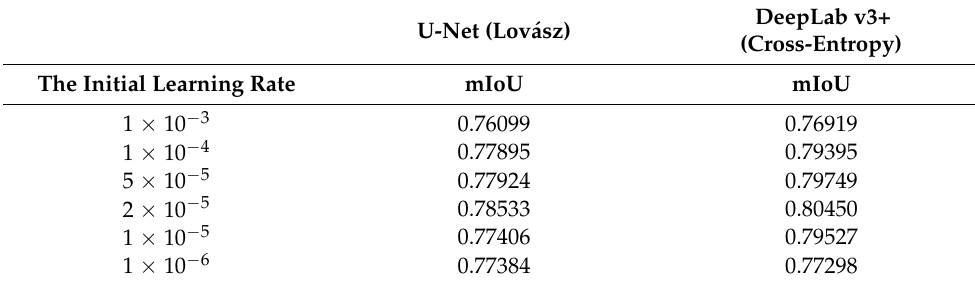
Table 4. Ablation study for the initial learning